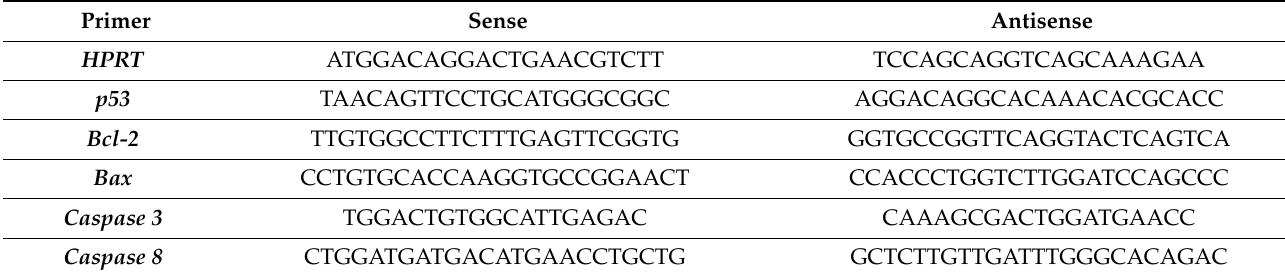
Table 2. The primer sequences of